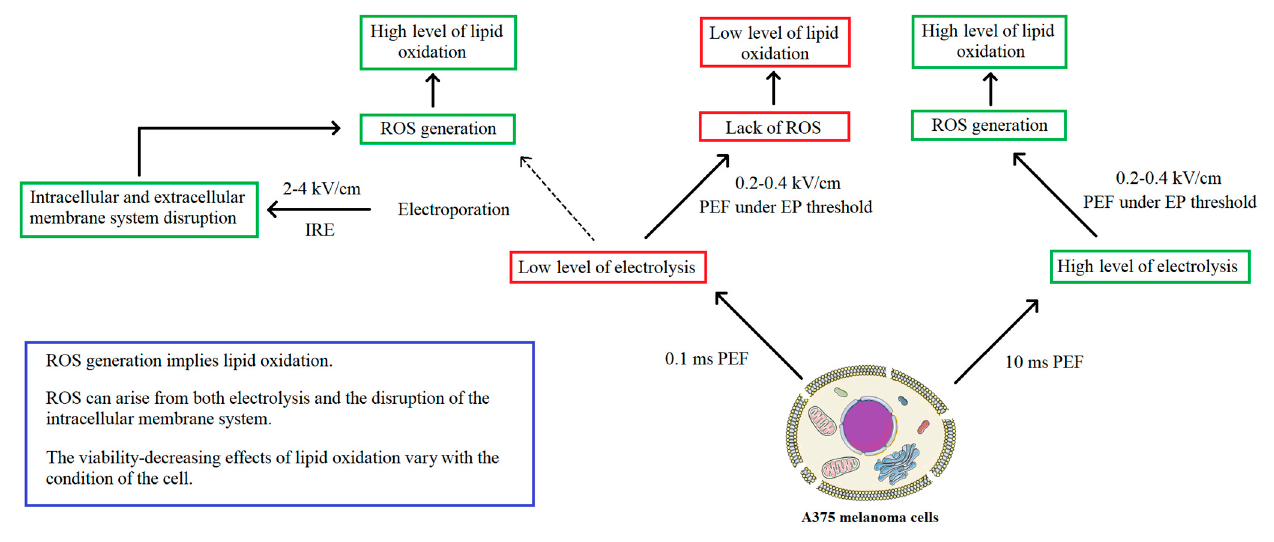
Figure 8. Mechanisms of ROS generation during PEF treatment.